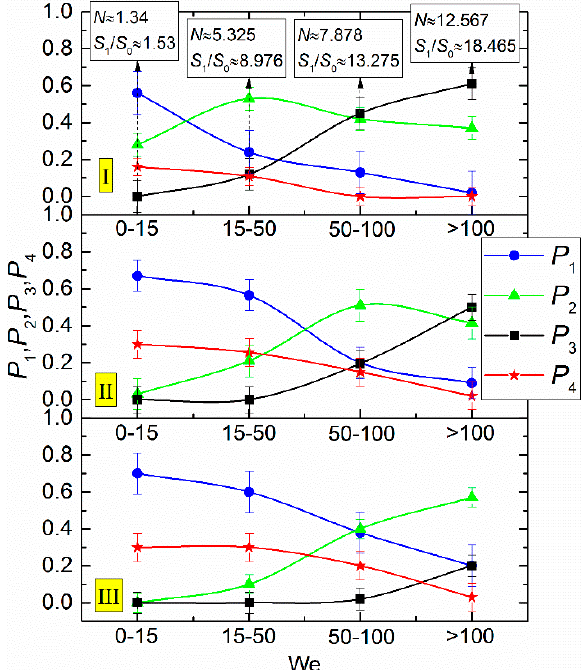
Figure 6. Frequency of each of four droplet interaction modes ( P 1 —coalescence, P 2 —separation, P 3 —disruption, P 4 —bounce) when varying temperature of gas-vapor-droplet medium in collision area (due to supply of gas and liquid with a given initial temperature): I—20 °C; II—200 °C: III—500 °C.